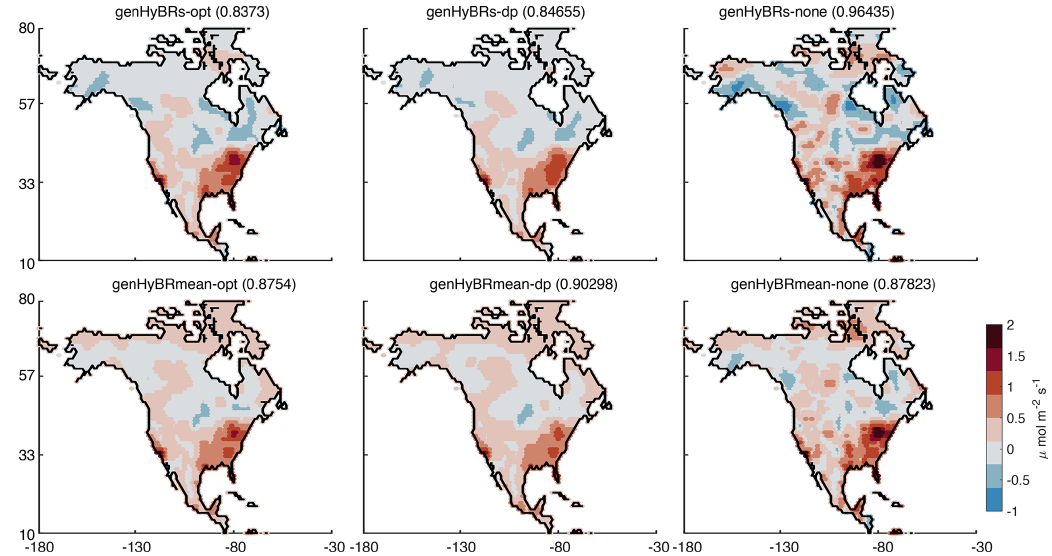
Figure 7. One-year case study: reconstructed fluxes, averaged over 1 year, are provided for genHyBRs and genHyBRmean for various parameter choices. These results correspond to the 50% noise level, and relative error norms of average fluxes over 1 year are provided in the